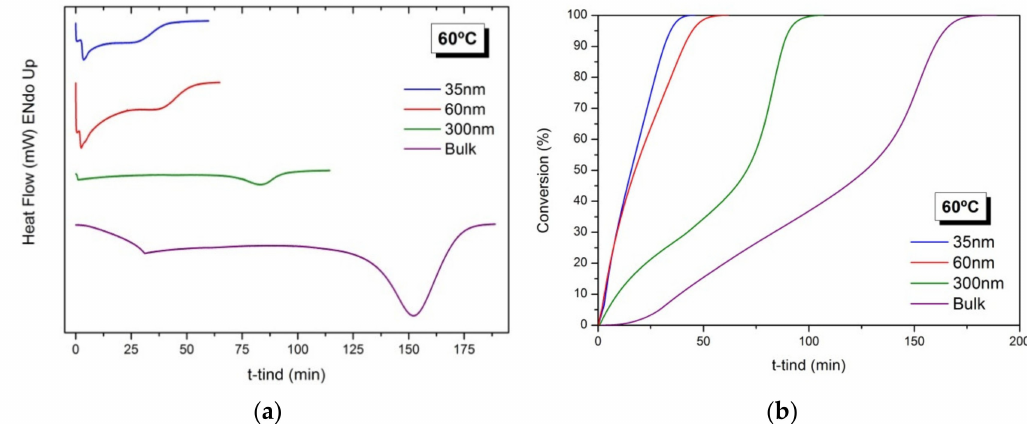
Figure 2. Free radical polymerization of BMA at 60 ◦ C in confinement in AAO templates of 35, 60 and 300 nm of pore diameters and in bulk conditions. ( a ) Thermograms corresponding to the heat generated during the reactions and ( b ) Evolution of the conversion (%) as a function of time